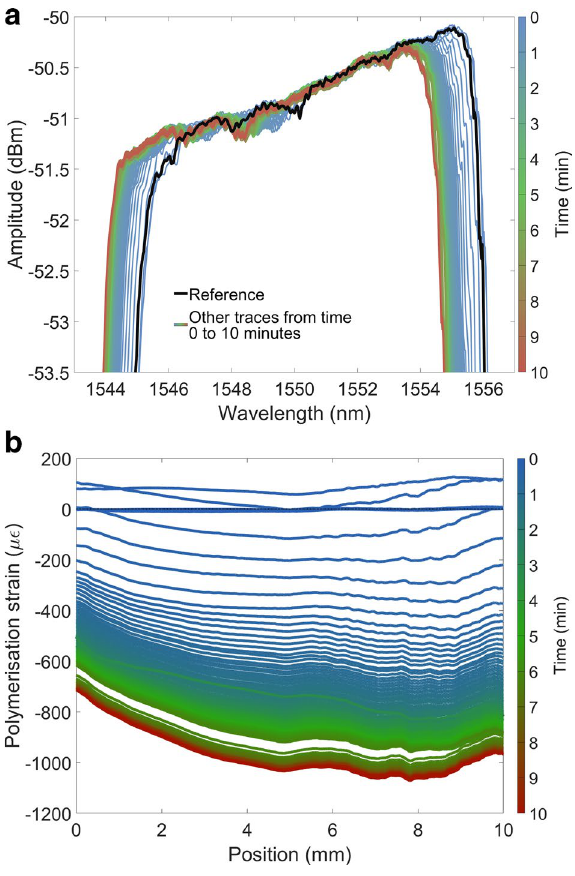
Figure 4. ( a ) Changes in the CFBG spectra due to PS strain, ( b ) evolution of PS strain within the dental composite for a duration of 10 min from cure initiation measured by the CFBG